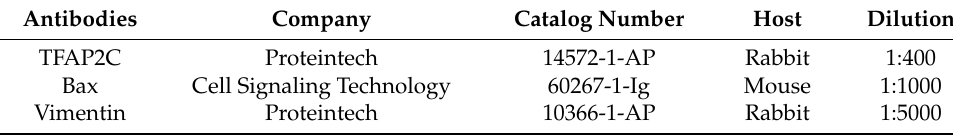
Table 2. Antibodies used in IHC.